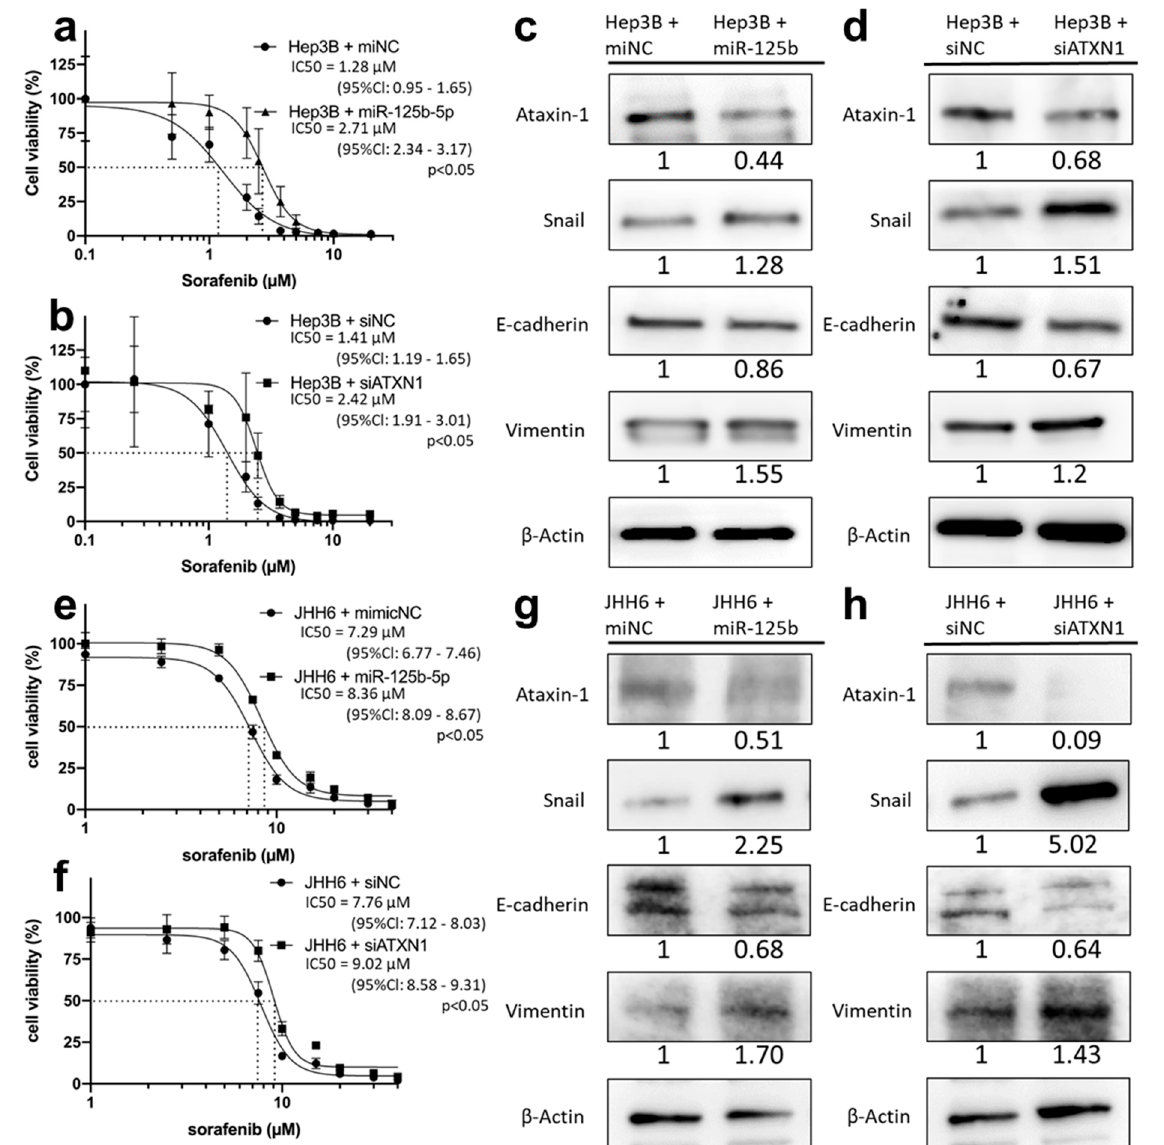
Figure 6. Forced expression of miR-125b-5p or knockdown of ATXN1 gene induces sorafenib resistance and EMT in Hep3B and JHH6 cells. ( a ) Hep3B cells were transfected with miR-125b-5p mimic (Hep3B-miR125b) or miNC (Hep3B-miNC). They were exposed to sorafenib, and cell viability was assessed by WST assay. ( b ) Hep3B cells were transfected with siATXN1 (Hep3B-siATXN1) or siNC (Hep3B-siNC) and exposed to sorafenib. Cell viability was assessed by WST assay. ( c ) Expression of ATXN1 and EMT markers (E-cadherin, Snail, vimentin) in Hep3B-miNC and Hep3B-miR125b cells was examined by western blot analysis. Densitometry analysis indicates relative protein levels from one representative of three independent experiments. Numbers below the bands represent protein expression normalized to β -actin. ( d ) Expression of ATXN1 and EMT markers in Hep3B-siNC and Hep3B-siATXN1 cells was examined by western blot analysis. ( e ) JHH6 cells were transfected with miR-125b-5p mimic (JHH6-miR125b) or miNC (JHH6-miNC). They were exposed to sorafenib, and cell viability was assessed by WST assay. ( f ) JHH6 cells were transfected with siATXN1 (JHH6-siATXN1) or siNC (JHH6-siNC) and exposed to sorafenib. Cell viability was assessed by WST assay. ( g ) Expression of ATXN1 and EMT markers (E-cadherin, Snail, vimentin) in JHH6-miNC and JHH6-miR125b cells was examined by western blot analysis. ( h ) Expression of ATXN1 and EMT markers in JHH6-siNC and JHH6-siATXN1 cells was examined by western blot analysis. Next, we transfected miR-125b-5p or siATXN1 into JHH6 cells (derived from hepatitis C virus positive HCC; JHH6-miR125b, JHH6-siATXN1). The IC50 of sorafenib against JHH6-miR125b was significantly higher compared with JHH6 cells transfected with